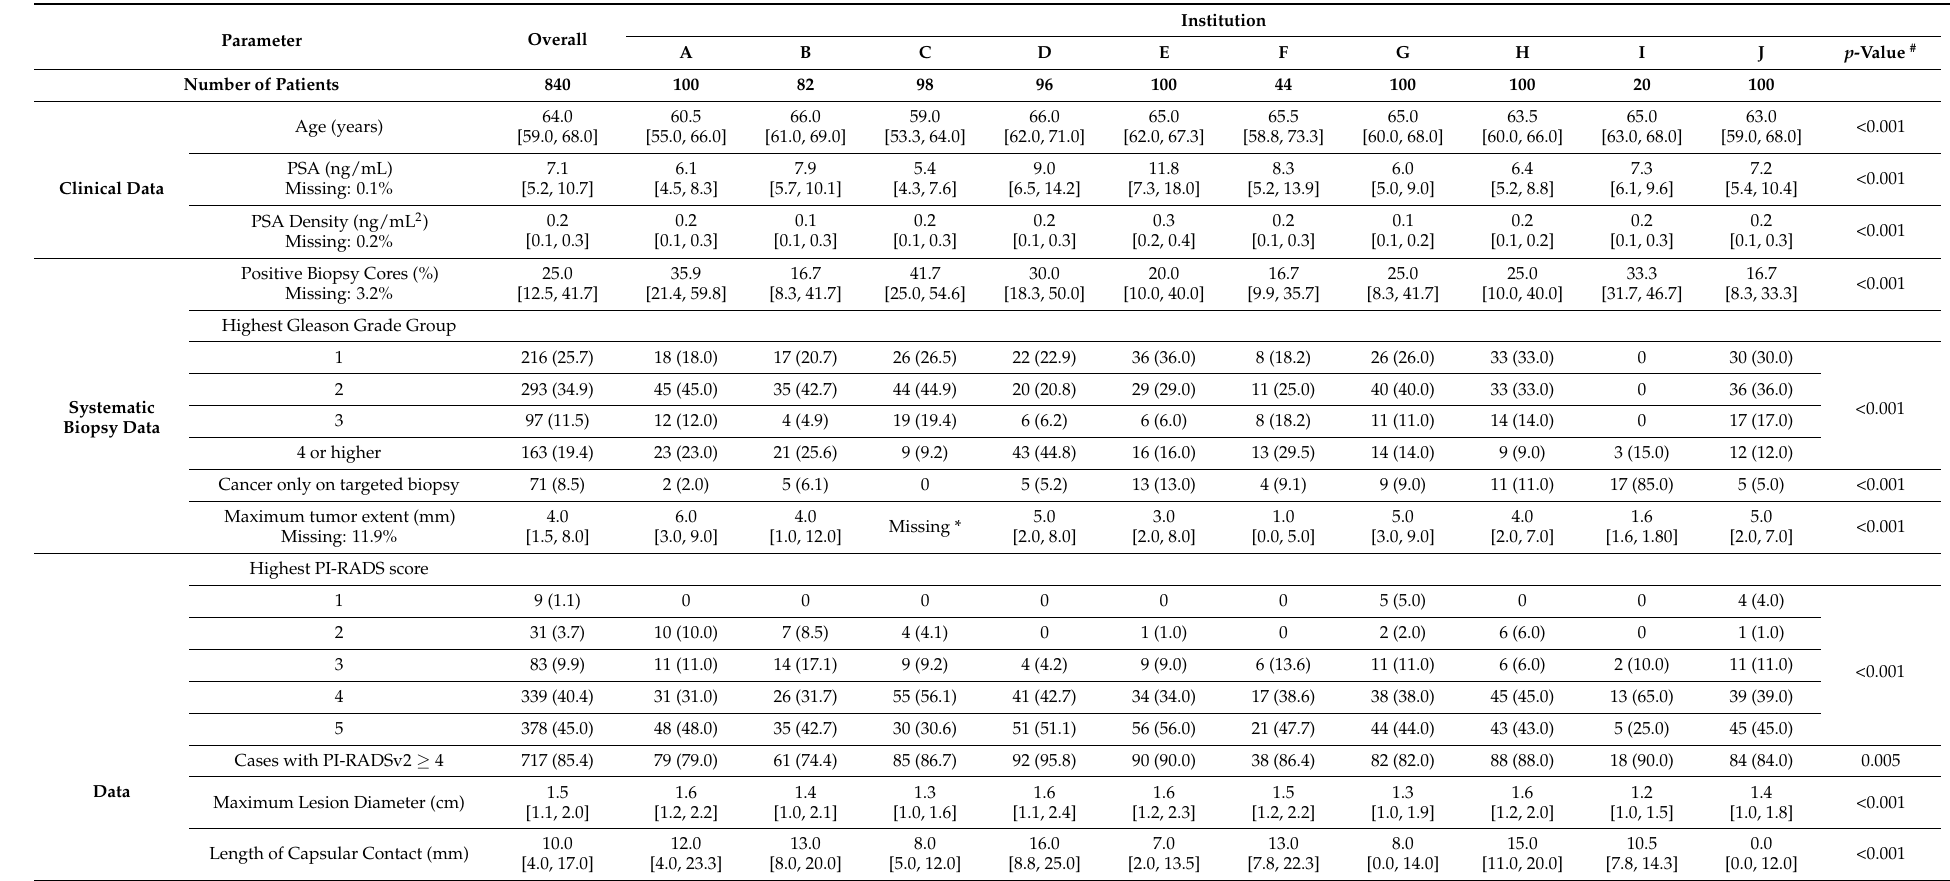
Table 2. Clinical, biopsy, and MRI-derived data for the entire study cohort and every participating institution. Continuous variables are presented as medians (interquartile range); # for inter-institutional comparisons; * only data on relative core involvement submitted, # p -values for inter-institutional comparisons. Parameter Overall